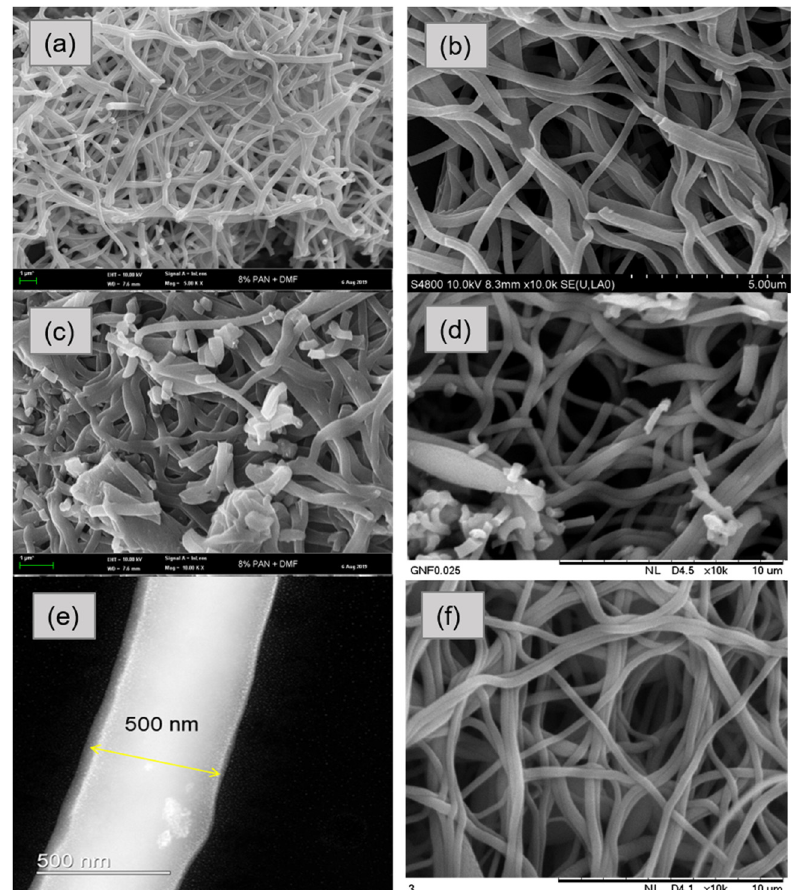
Figure 4: FE - SEM images of pristine ACNFs at di ff erent magni fi cations: ( a ) 5,000 × ; ( c ) 10,000 × ; ( e ) 100,000 × ; and with di ff erent loadings of GRHC at 10,000 × ( b ) GRHC/ACNF0.01; ( d ) GRHC/ACNF0.05; ( f ) GRHC/ACNF0.1.